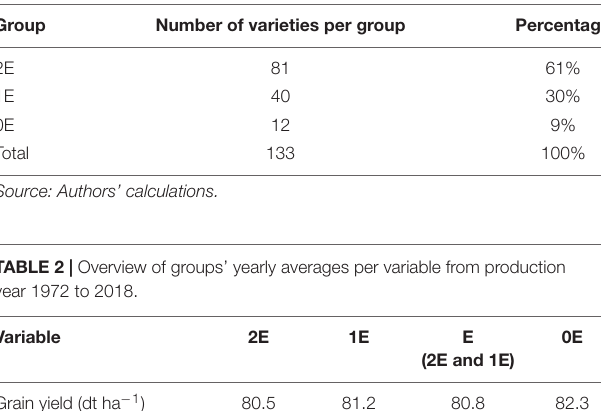
TABLE 1 | Distribution of varieties per group.